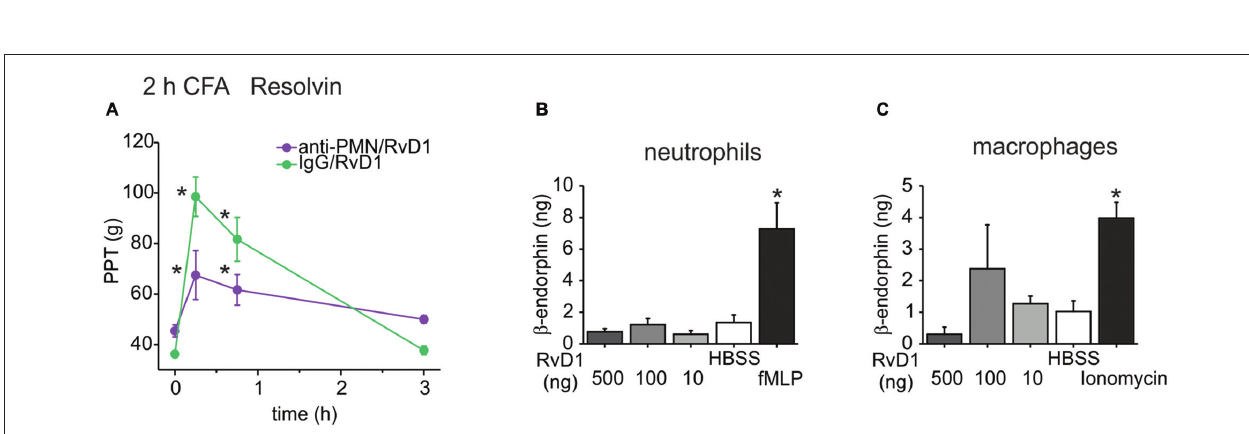
( Figure 2C ). Similar to RvD1, intraplantar naloxone prevented the HC-030031-induced rise in mechanical nociceptive